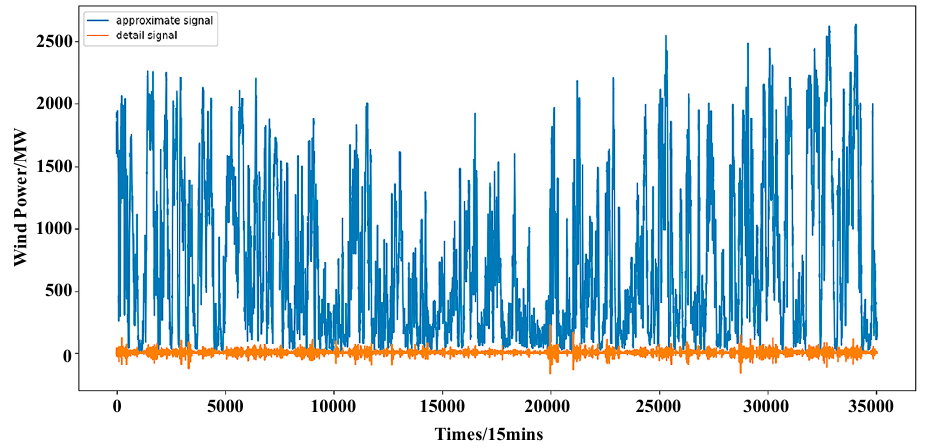
Figure 6. Results of DWT for wind farm 1.